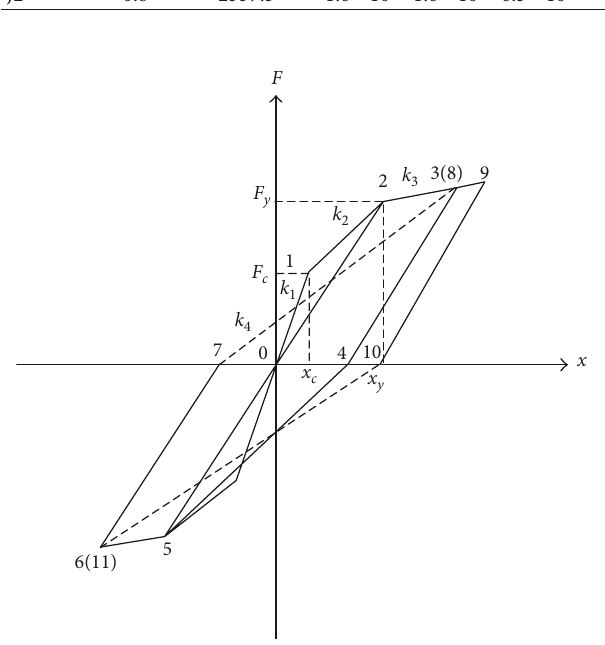
Figure 8: Trilinear restoring